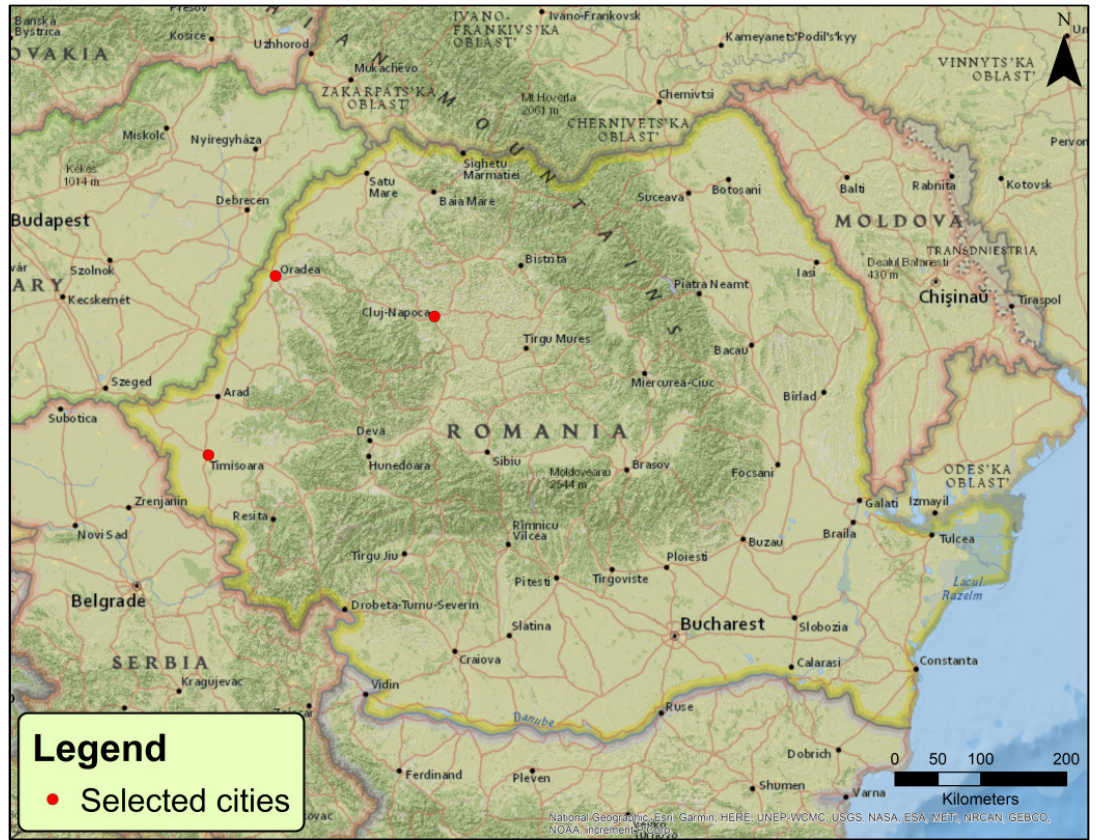
Figure 1. Selected cities in the